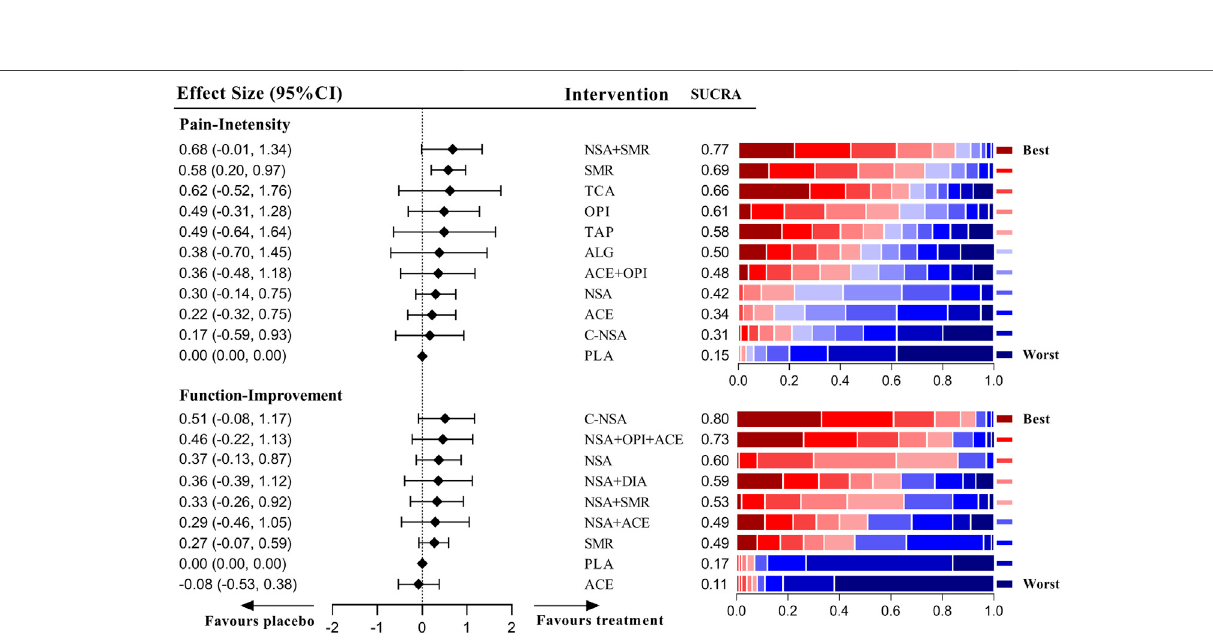
Frontiers in Pharmacology |